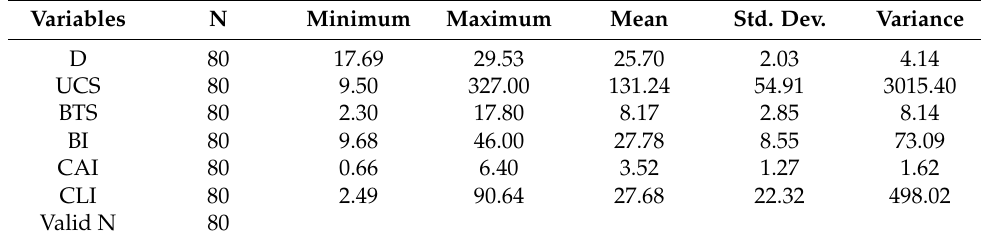
Table 5. Summary of rock properties and data ranges used for this paper [32]. Variables